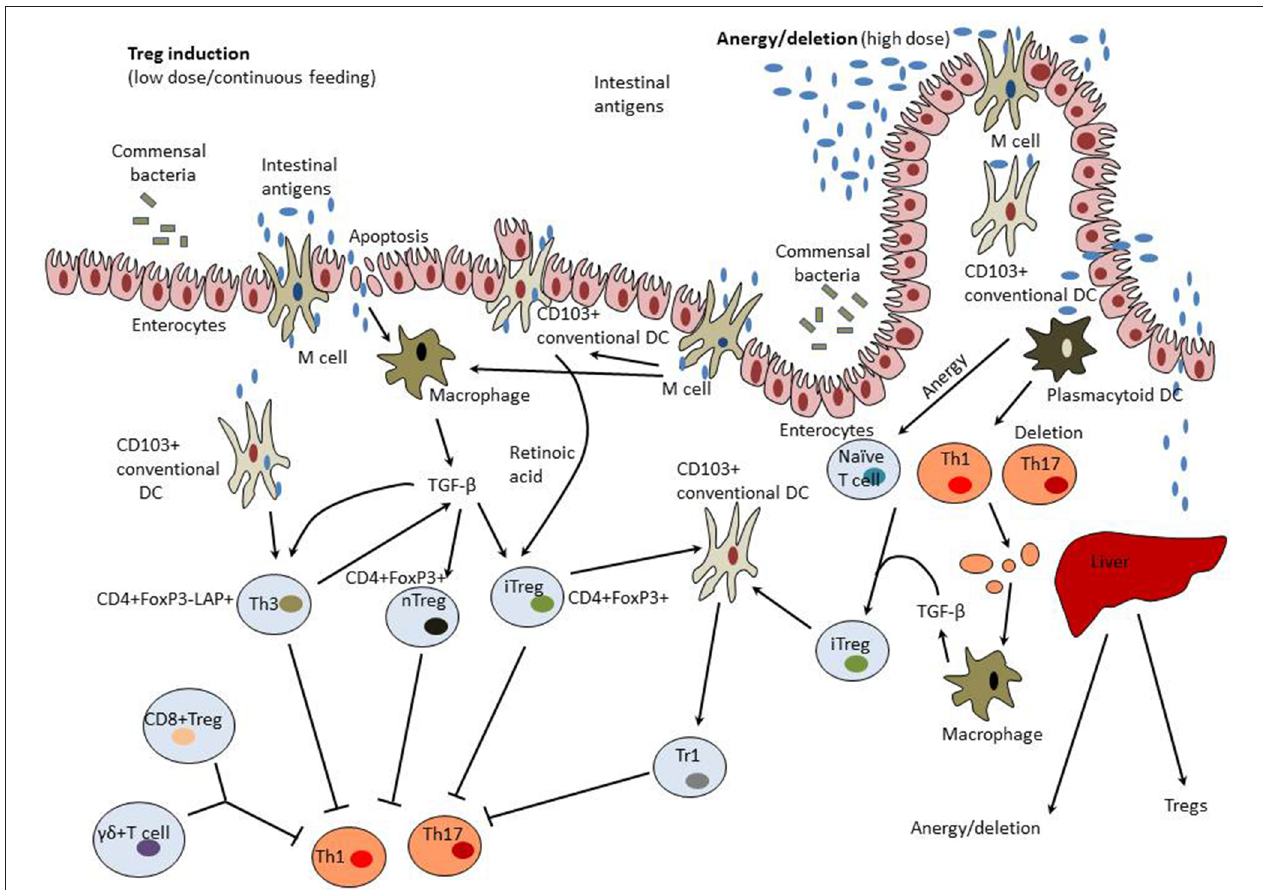
lymph nodes and involves C-C motif receptors (CCR)-7 and -9. Low doses of intestinal antigen lead to the induction of Tregs while high antigen doses result in tolerance induction preferentially through the mechanisms of anergy and deletion. Macrophages activated by clearance of apoptotic T cells and enterocytes become to produce TGF- β and therefore could possess tolerogenic properties. In the liver, high antigen doses could be taken up by tolerogenic plasmacytoid DCs that induce anergy/deletion and Tregs. A variety of Tregs could be induced including CD4 + CD25 + Foxp3 + natural Tregs (nTregs), CD4 + CD25 + Foxp3 + iTregs, latency-associated peptide (LAP) + Tregs (Th3 cells), CD8 + Tregs, and γδ T